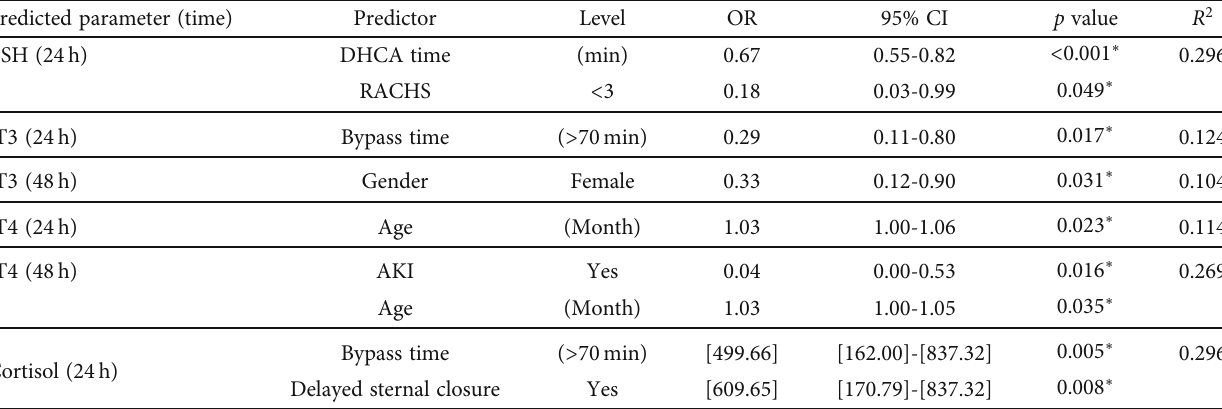
Table 4: Predictors of the change in TSH, T3, T4, and cortisol postcardiac surgery (stepwise linear regression). Predicted parameter (time)